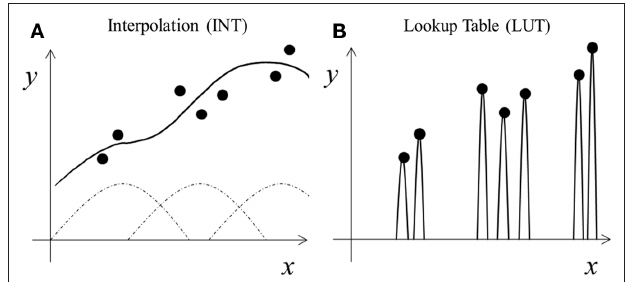
Figure 1 | Schematic illustration of two learning styles. (A) Interpolation (INT) learning: broad tuning functions (dashed curves) are combined (solid curve) to capture the trend of the training data (dots). (B) Lookup table (LUT) learning: narrow tuning functions are scaled (solid curves) to match each training